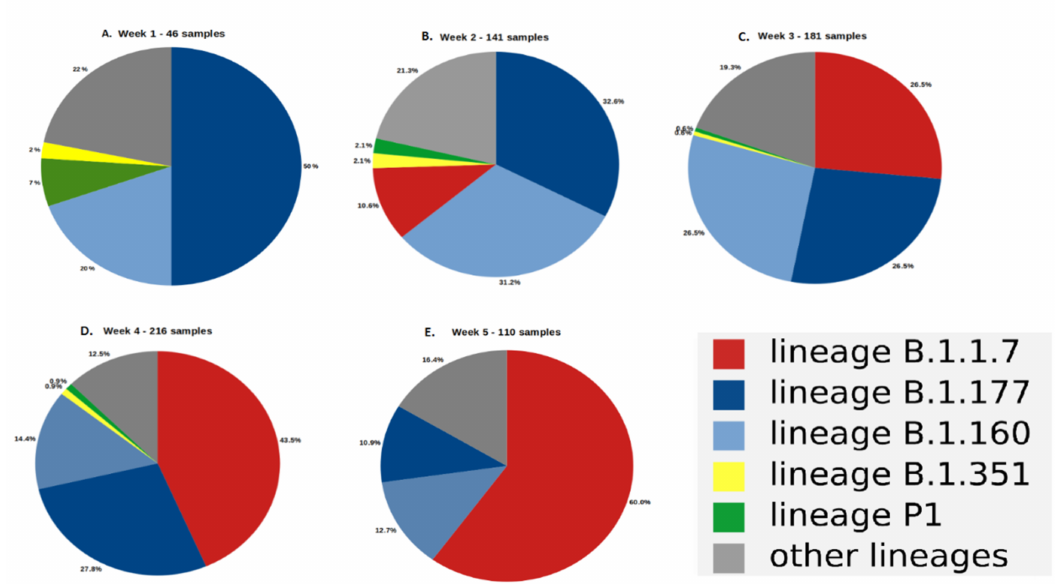
Figure 1. The circulating forms of SARS-CoV-2 on Toulouse urban area during January 2021 and early February. ( A ): week 1 (46 samples), ( B ): week 2 (141 samples), ( C ): week 3 (181 samples), ( D ): week 4 (216 samples), ( E ): week 5 (110 samples).